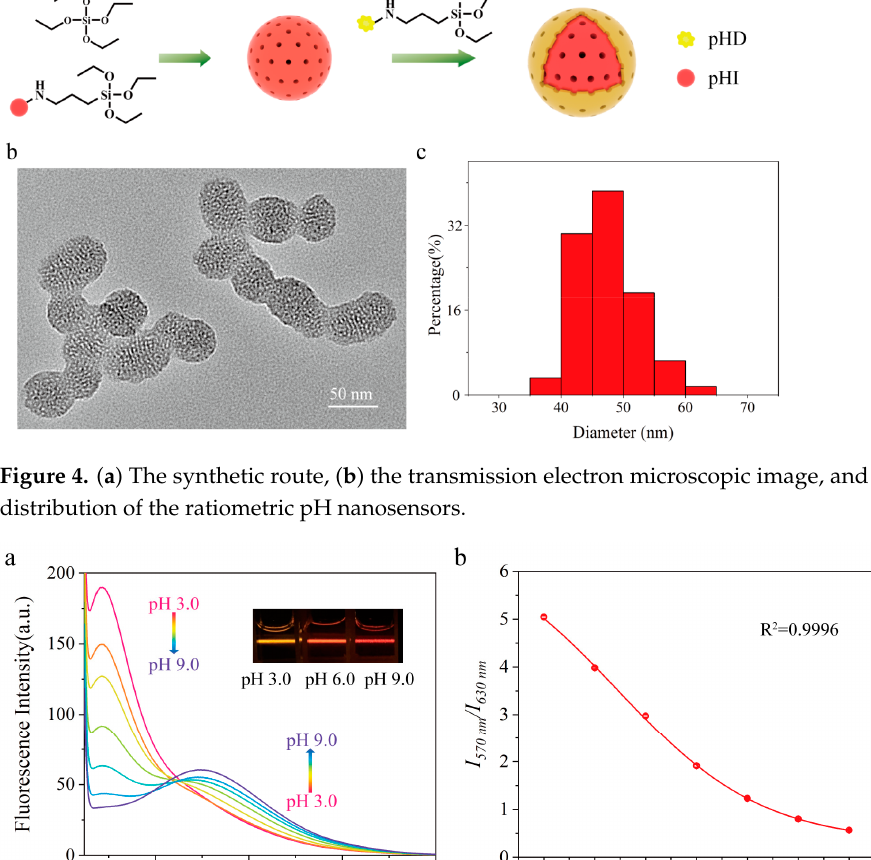
Figure 4. ( a ) The synthetic route, ( b ) the transmission electron microscopic image, and ( c ) the size distribution of the ratiometric pH nanosensors.